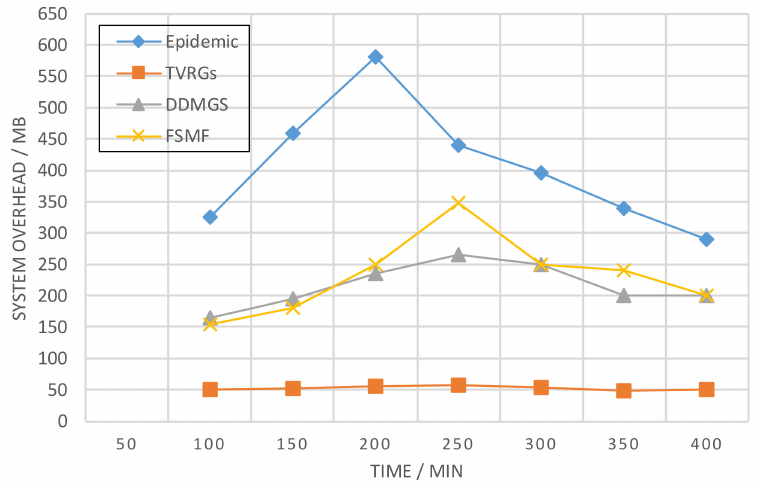
Figure 10. The relationship between average delay and simulation time.